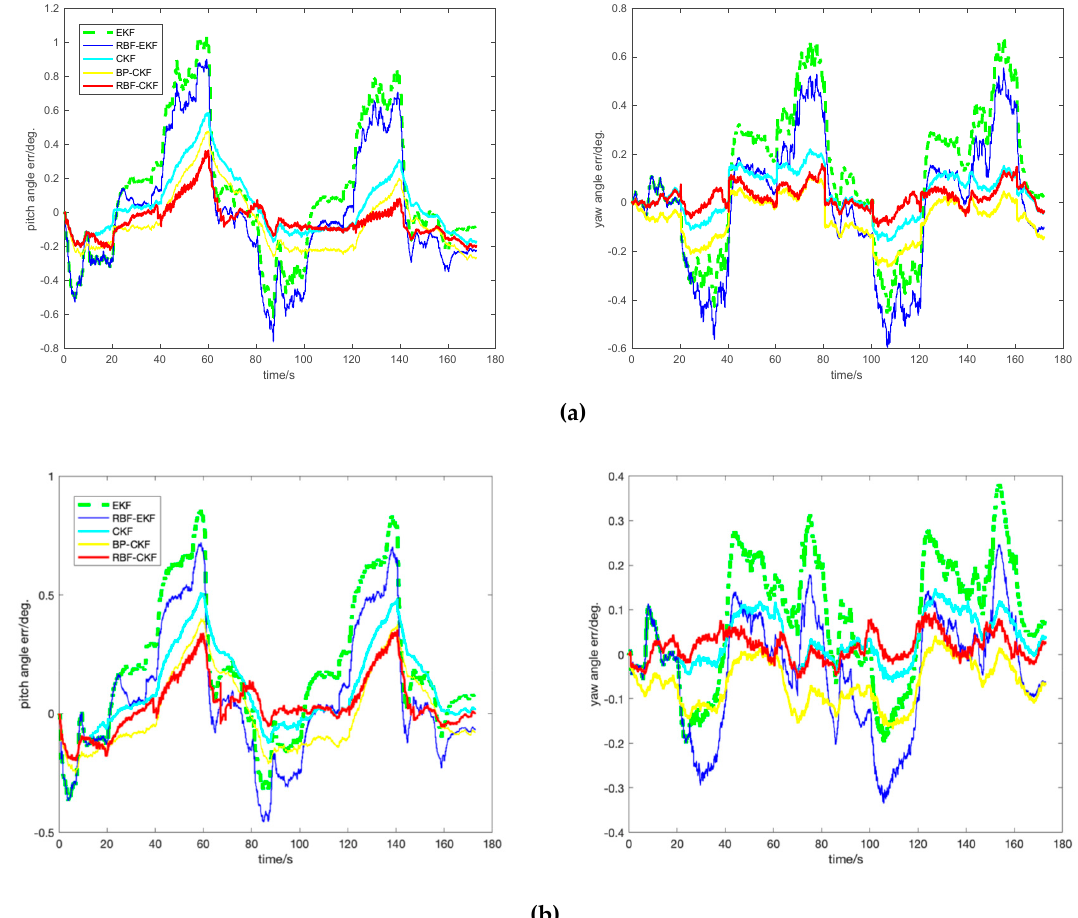
Figure 12. ( a ) The attitude errors of experiment one; ( b ) The attitude errors of experiment two.